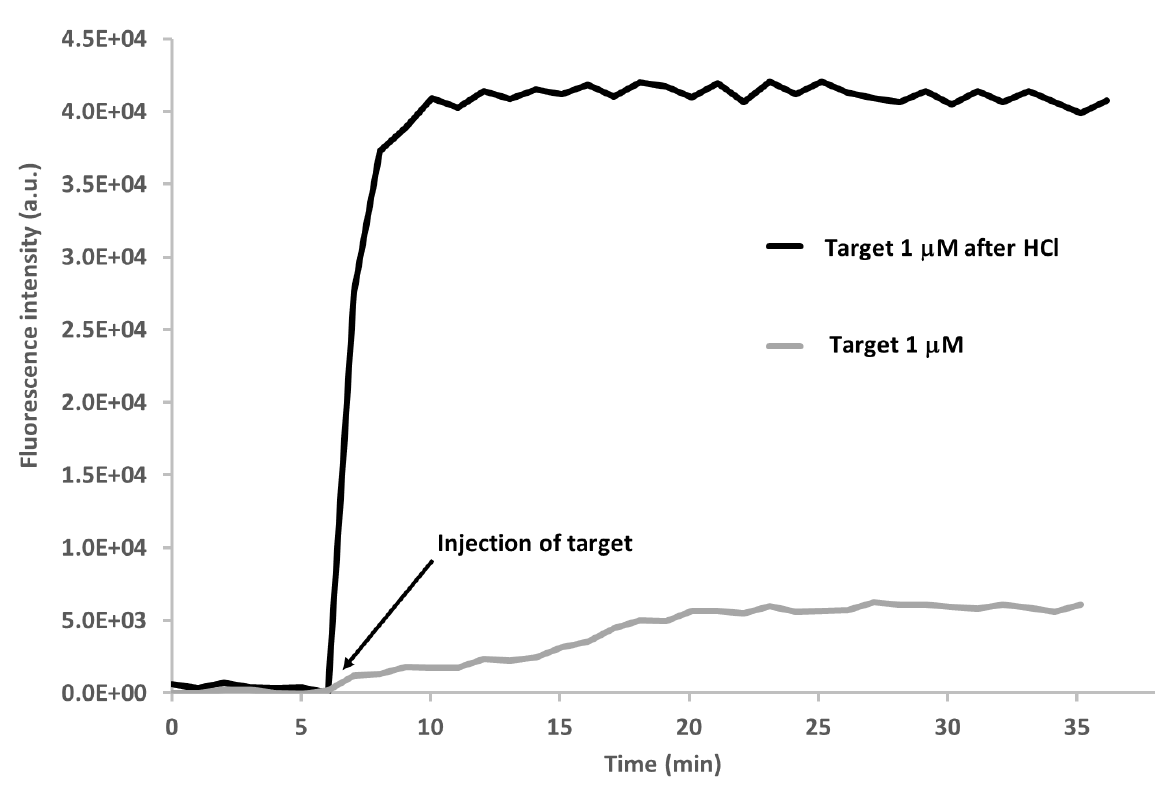
Figure 9. Kinetics of the fluorescence signal of the MB onto the nanotip after incubation with the target 1 µM without any previous treatment and after the treatment with HCl 2